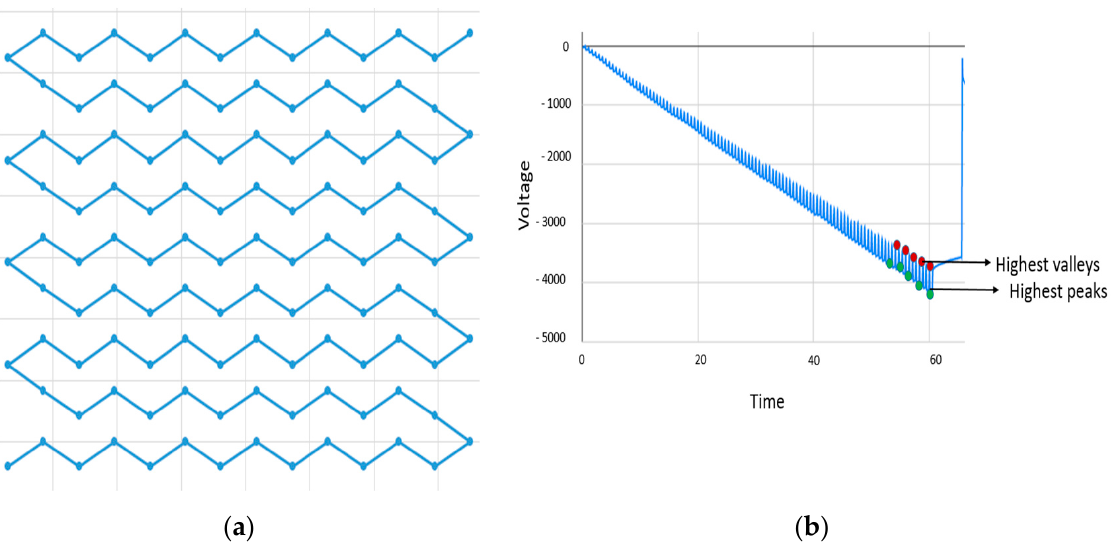
Figure 11. ( a ) Movement pattern of automated foot controlled by the G-code to give a controlled motion. ( b ) Electrostatic characterization graphs plotted with the new plotter with the five highest peaks and valleys indicated.